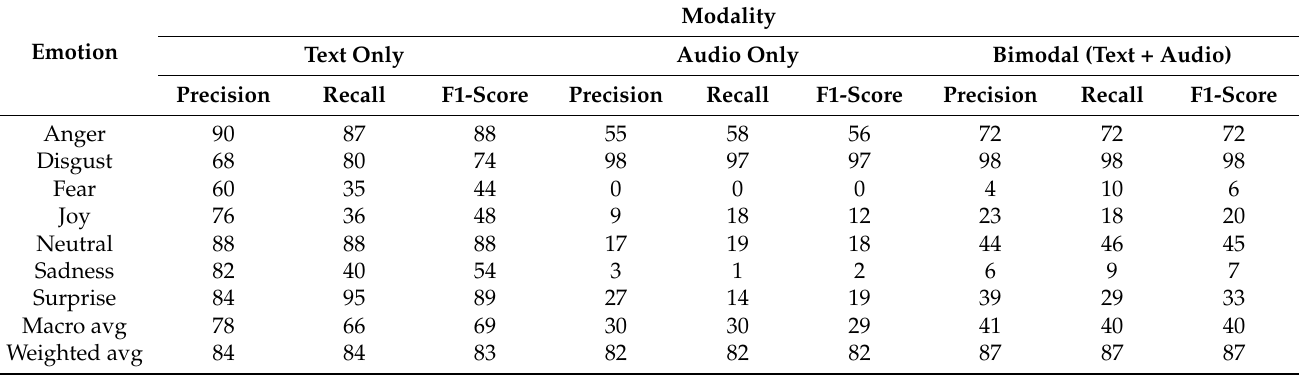
Table 3. Classification report results for the MELD on text, audio, and bimodal modalities in the function of (Precision, Recall, and F1-score) (Unit = %).